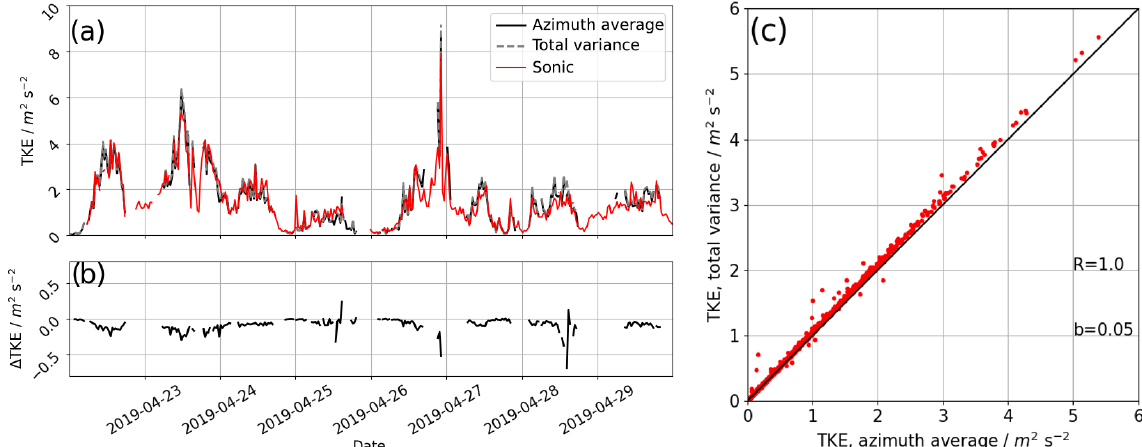
Figure 5. Time series of TKE from lidar retrievals compared to a sonic anemometer at 90m above ground level (a) , the difference between the lidar retrieval with averaged variances (Eq. 20) at specific azimuth angles θ to the modified total variance method (Eq. 21) (b) , and the scatterplot for the whole experimental period (c) .